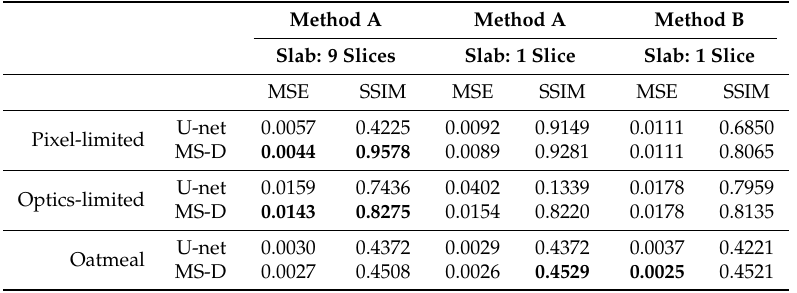
Table 6. Comparison of the MSE and SSIM between MS-D and U-net for all three datasets. For each dataset and metric, the best results are shown in